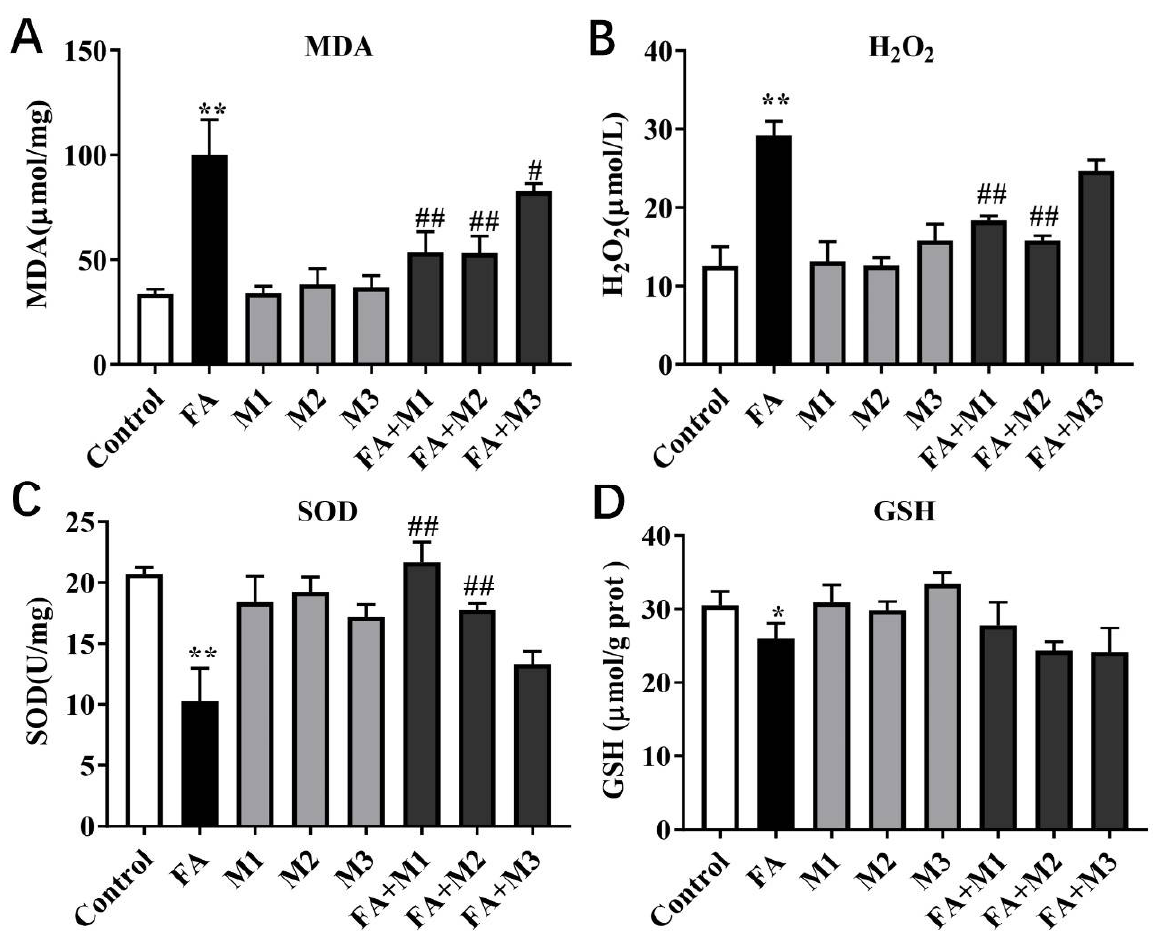
Figure 3. The effect of myricetin on oxidative stress in primary calf hepatocytes. Hepatocytes were treated with 100 µ M (M1), 50 µ M (M2), 25 µ M (M3), or RPMI-1640 basic medium (Control) with or without 1.2 mM FA. ( A ) Concentration of malondialdehyde (MDA). ( B ) Concentration of hydrogen peroxide (H 2 O 2 ). ( C ) Activity of superoxide dismutase (SOD). ( D ) Concentration of glutathione (GSH; gprot = g protein). Data were analyzed using a two-way repeated-measure (RM) ANOVA with subsequent Bonferroni correction. The data presented are the means ± SEM; * p < 0.05, ** p < 0.01 indicate differences from control. # p < 0.05, ## p < 0.01 indicate differences from the cells incubated with FA.